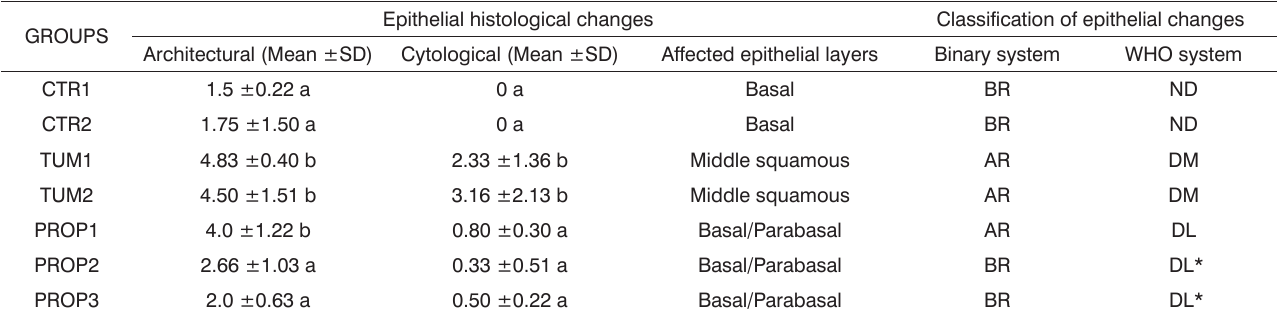
Table 1. Analysis of mean scores of epithelial histological changes and the classification according to the WHO and the binary system